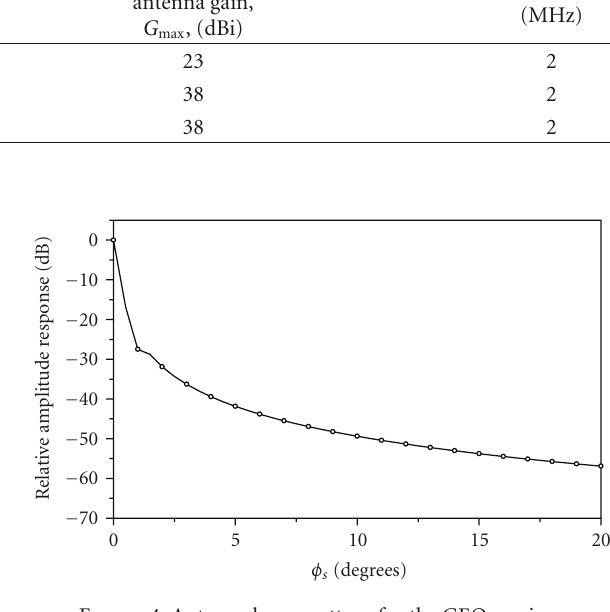
Figure 4: Antenna beam pattern for the GEO